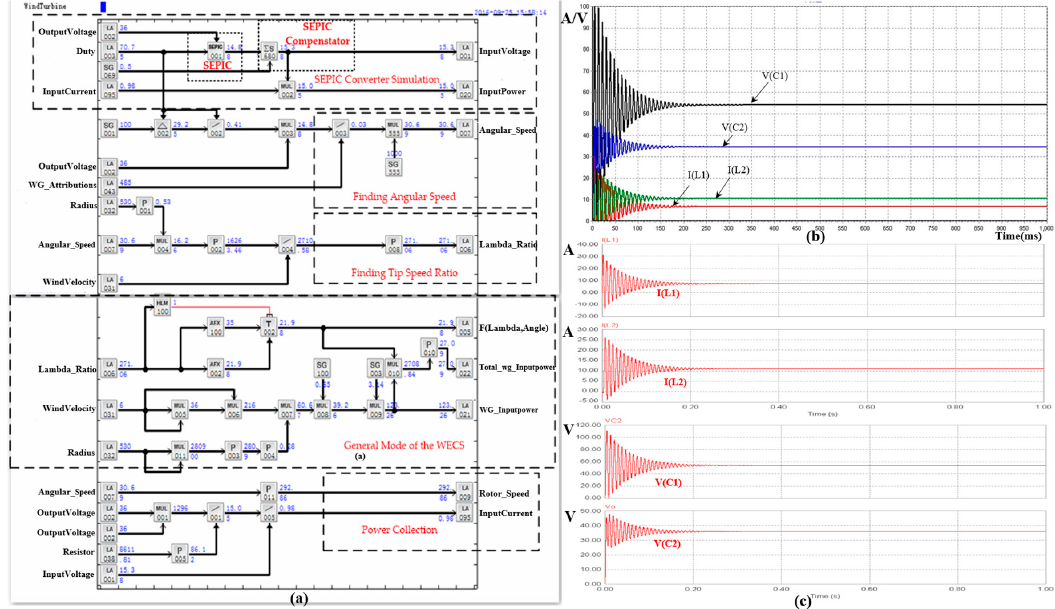
Figure 8. ( a ) The parts of control logical configuration of WECS system; ( b ) The dynamic current curves of inductors L1, L2 and dynamic voltage curves of capacitors C1, C2 when the power switch is on and off; ( c ) The simulation results on the MATLAB software under the same conditions .